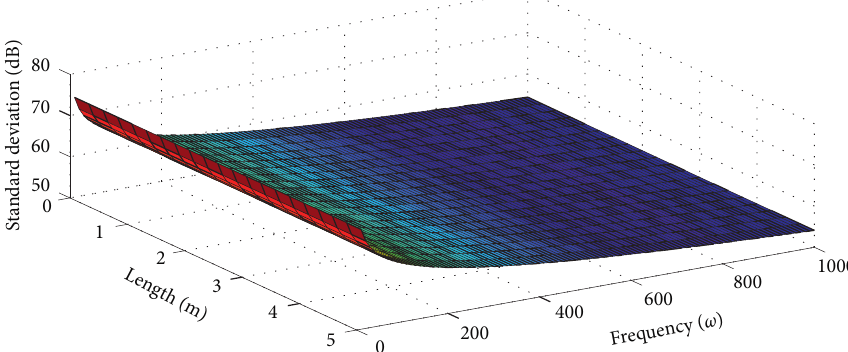
Figure 14: Standard deviations of energy densities of the beam. The reference energy density is 10 − 12 J/m 2 .